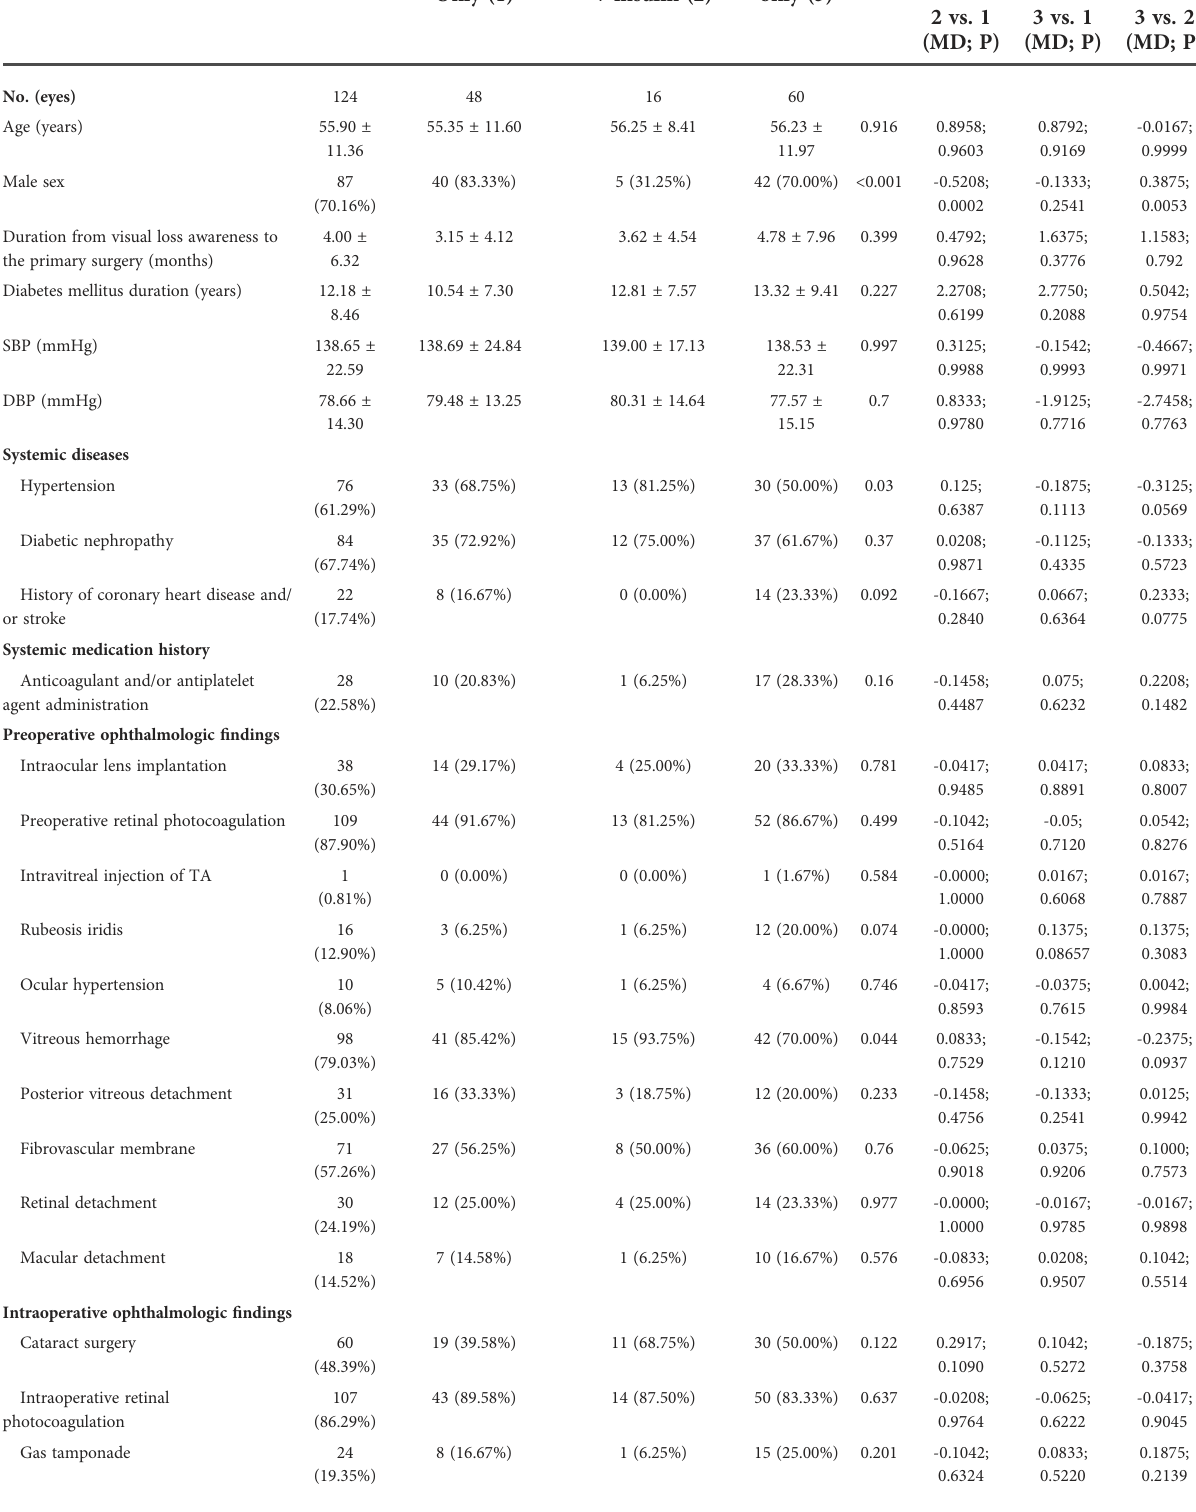
TABLE 1 Baseline characteristics of